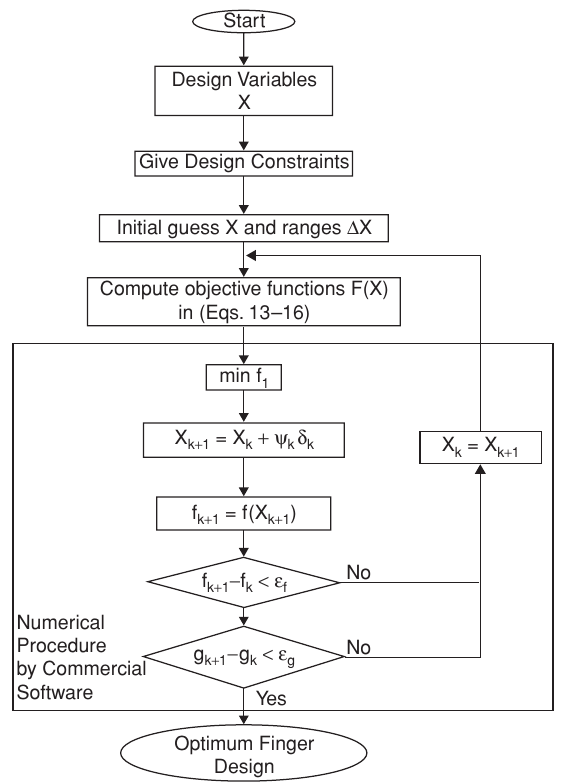
Figure 11 A numerical procedure using a commercial software package for solving the design optimization problem for finger-driving mechanisms.